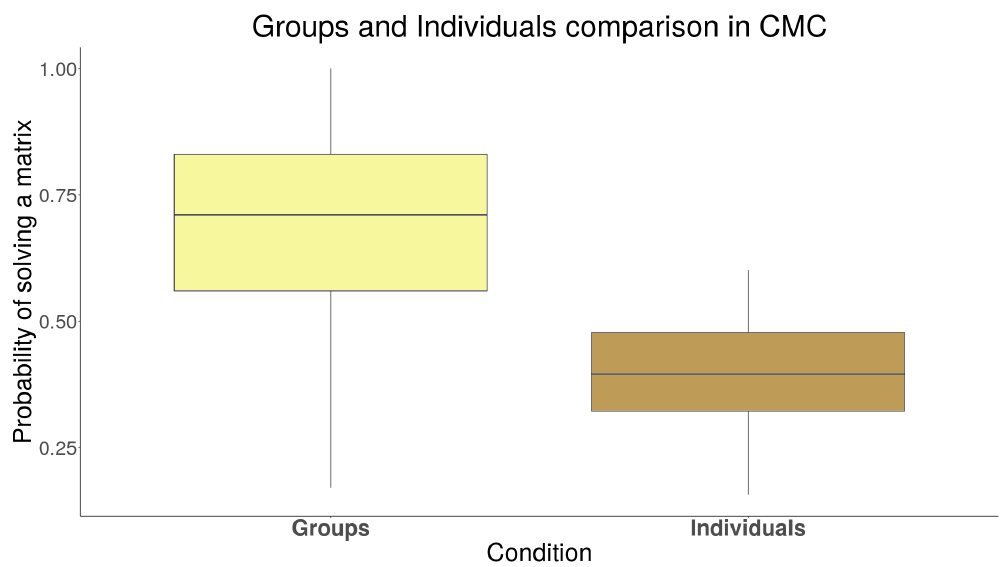
Figure 5. Comparison between individuals’ and CMC groups’ performance. A box-plot is shown, comparing the performance in RAPM of the groups involved in computer-mediated-communication (CMC) and the score obtained in the test by teammates when they worked individually (teammates’ average RAPM score). The horizontal lines in the box indicates the median values, respectively Med = 0.733 for groups and Med = 0.386 for individuals.